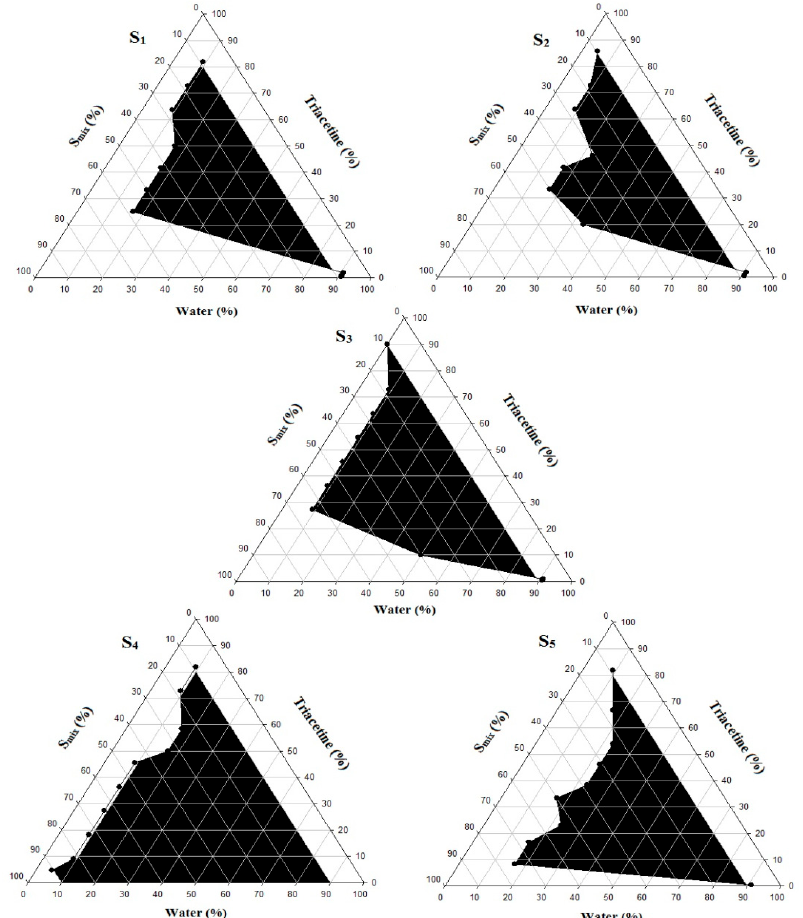
Figure 2. Pseudo-ternary phase diagrams of the quaternary systems containing Triacetin/Kolliphor EL/PEG 400/water at various S mix ratios. S 1 : S mix (3:1), S 2 : S mix (2:1), S 3 : S mix (1:1), S 4 : S mix (1:2), S 5 : S mix (1:3).